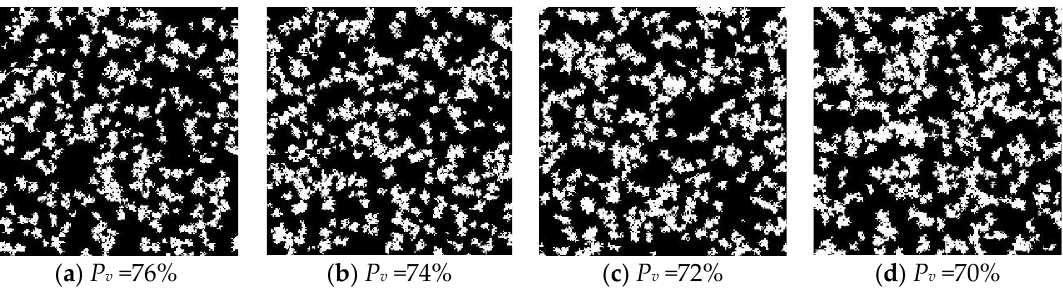
Figure 4. C-S-H models with different porosity.